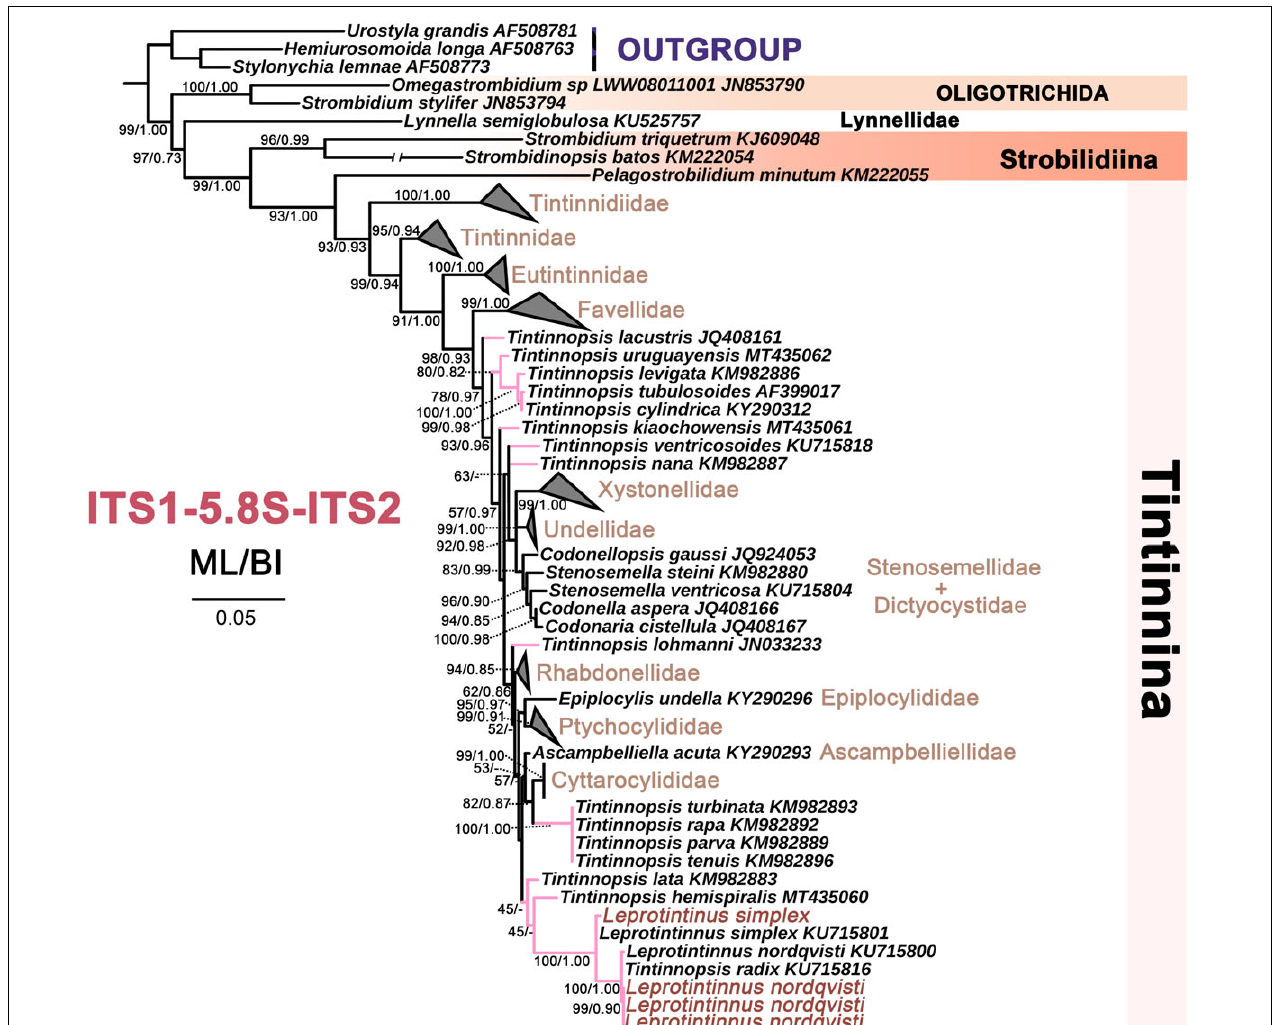
FIGURE 8 | The maximum likelihood (ML) phylogenetic tree is inferred from ITS1-5.8S rDNA-ITS2 sequences. Numbers at the nodes represent support values in the following order: ML and BI bootstrap values. The pink branch denotes the incertae sedis taxa in Tintinnina. The new sequences Leprotintinnus neriticus and L. simplex in the present work were indicated in red. A hyphen (–) represents support values too low (ML < 45%, BI < 0.70) and disagreements in topology between the BI and ML trees. The scale bar corresponds to 5 substitutions per 100